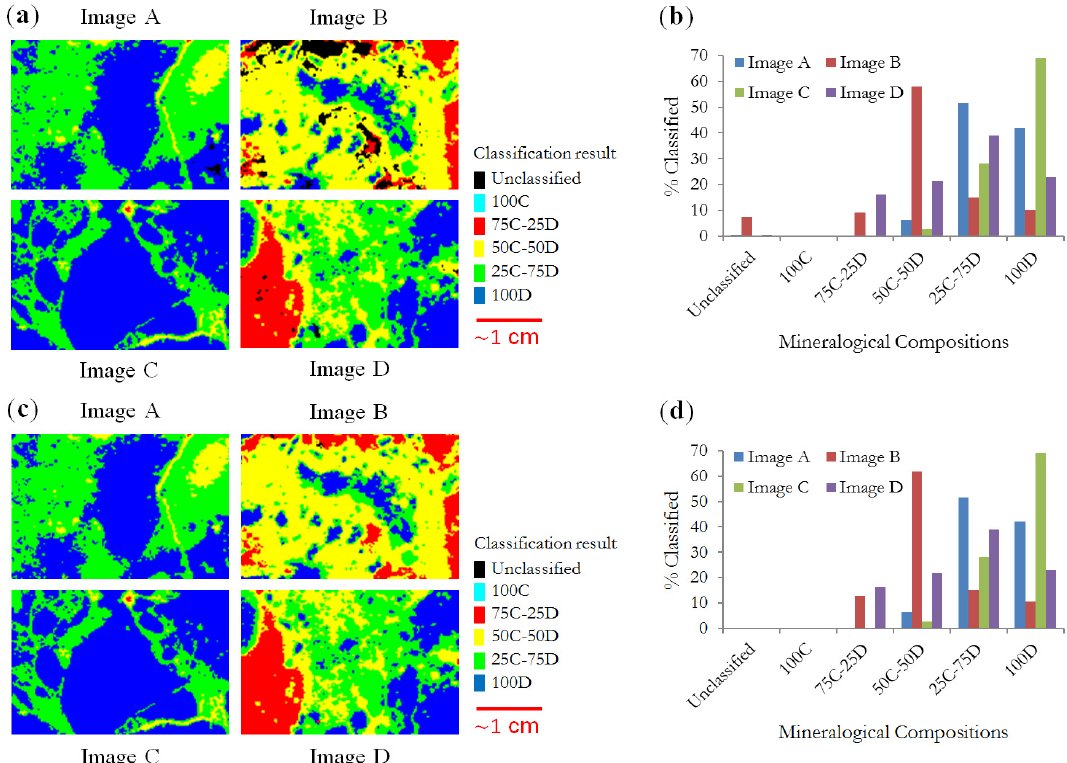
Figure 7. SAM classification results: ( a ) SAM images using a 0.1 radians threshold angle, ( b ) estimated proportion of classified minerals derived from (a) images, ( c ) SAM images using a 0.2 radians threshold angle, ( d ) estimated proportion of classified minerals derived from (c) images. The classification images illustrate roughly similar carbonate mineral abundances in different threshold angles. (C = calcite and D = dolomite, prefix numbers showing the mineral contents in